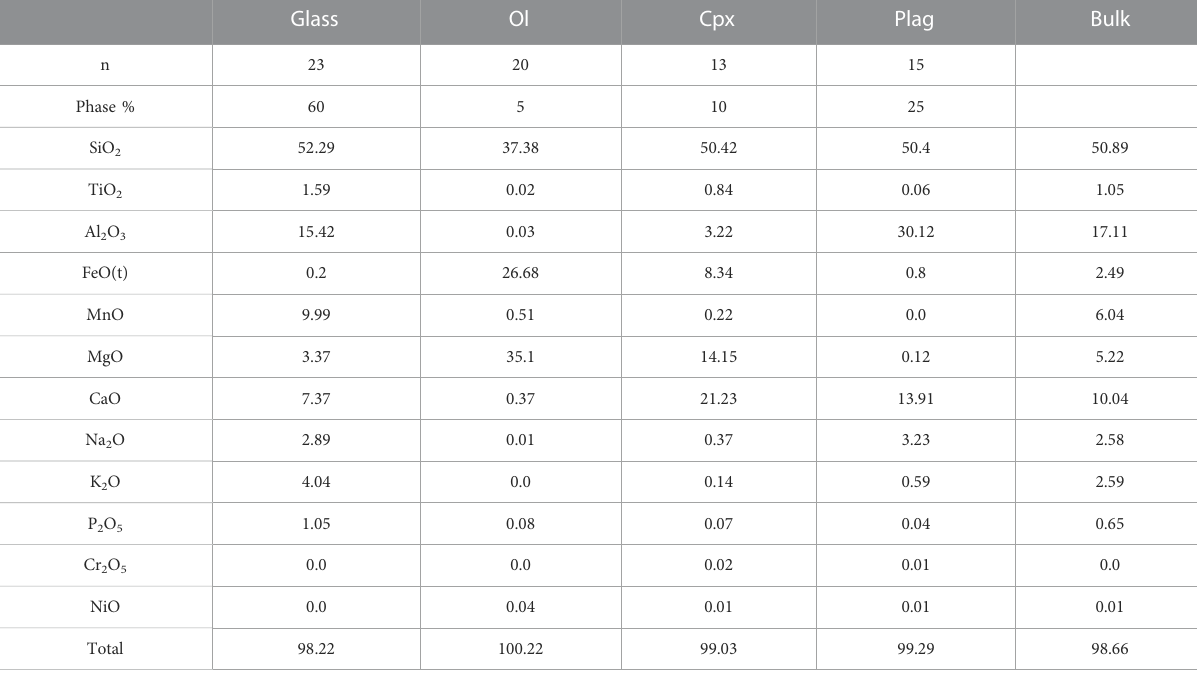
TABLE 2 Chemical composition of crystalline phases and glass measured in the ash sample collected with the RPAS on 11 September 2019. Glass